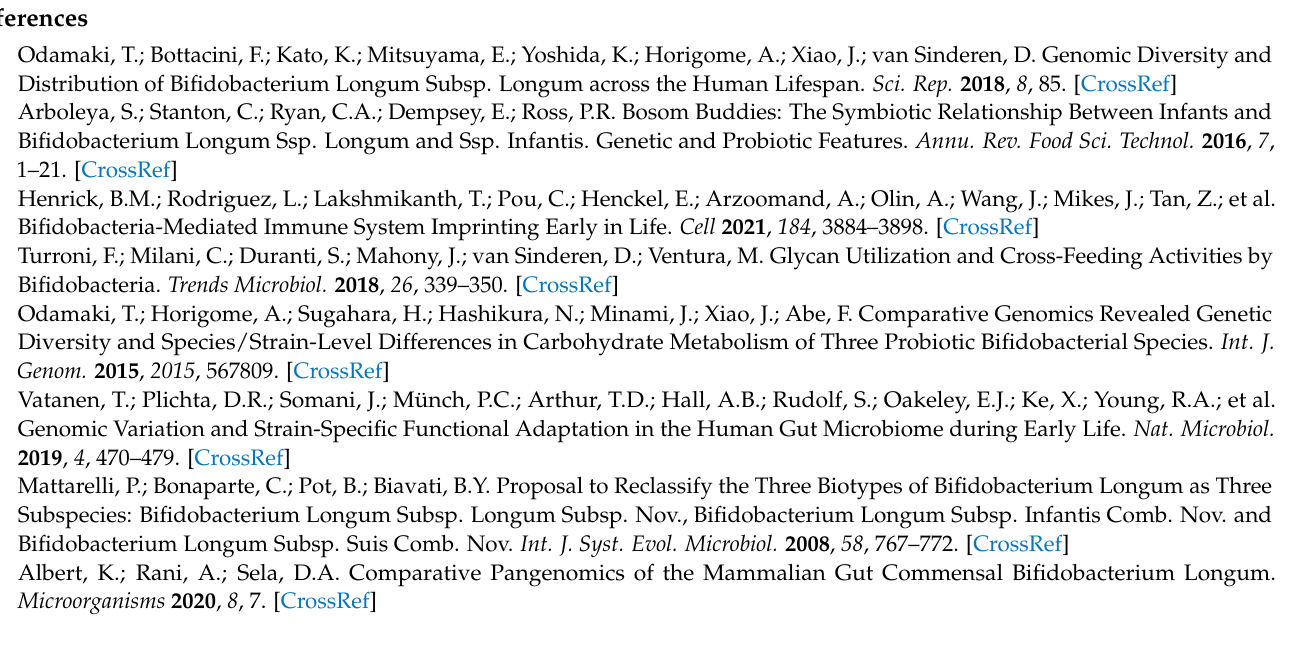
resistance heatmap, Table S1: Genomes features from public databases and Chilean isolates, Table S2: Virulence factors and antibiotic resistance information, Table S3: Plasmid and mobile elements in Chilean isolates, Table S4: Blast results of plasmid contigs, Table S5: Chilean isolates mobile